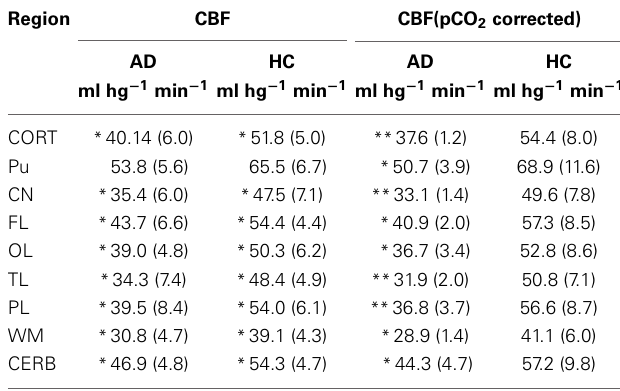
Table 3 | Regional absolute CBF measures before and after correction for PCO 2 (Rodell et al., 2012).